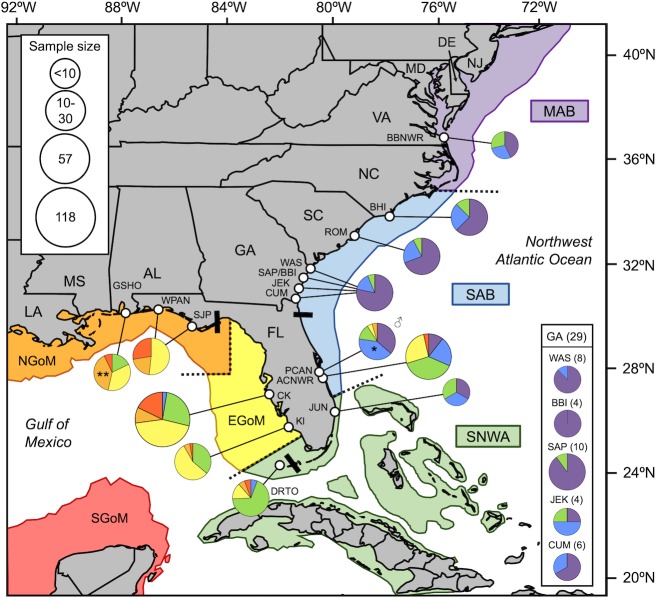
Summary of foraging-area destinations of adult loggerheads satellite tracked during post-breeding migrations in the NWA.Black bars separate beaches used by different recovery units: Northern, Peninsular Florida, Dry Tortugas, Northern Gulf. Breeding sites: BBNWR, Back Bay National Wildlife Refuge, Virginia (VA); BHI, Bald Head Island, North Carolina (NC); ROM, Cape Romain, South Carolina (SC); WAS, Wassaw Island, Georgia (GA); SAP, Sapelo Island, GA; BBI, Blackbeard Island, GA; JEK, Jekyll Island, GA; CUM, Cumberland Island, GA; PCAN, Port Canaveral Shipping Channel, Florida (FL; Asterisk indicates reproductively active adult males only; four non-reproductively active males excluded); ACNWR, Archie Carr National Wildlife Refuge, FL; JUN, Juno Beach, FL; DRTO, Dry Tortugas, FL; KI, Keewaydin Island, FL: CK, Casey Key, FL; SJP, St. Joseph Peninsula, FL; WPAN, Western Panhandle, FL; GSHO, Gulf Shores, Alabama (AL; Double asterisk includes one female that migrated in the Western Gulf of Mexico). Foraging areas: MAB, Mid-Atlantic Bight; SAB, South Atlantic Bight; SNWA, Subtropical Northwest Atlantic; EGoM, Eastern Gulf of Mexico; NGoM, Northern Gulf of Mexico; SGoM, Southern Gulf of Mexico. Data are from Arendt et al. [37–38], Ceriani et al. [9,16,22], Dodd and Byles [39], Evans et al. [40], Foley et al. [7], Girard et al. [41], Griffin et al. [42], Hardy et al. [43], Hart et al. [12,44–45], Hawkes et al. [6], Lamont et al. [46], Mansfield [47], Phillips [48], Plotkin and Spotila [49], Tucker et al. [8], Vander Zanden et al. [50] (S3 Table). Base map generated using the SEATURTLE.ORG Maptool [17].